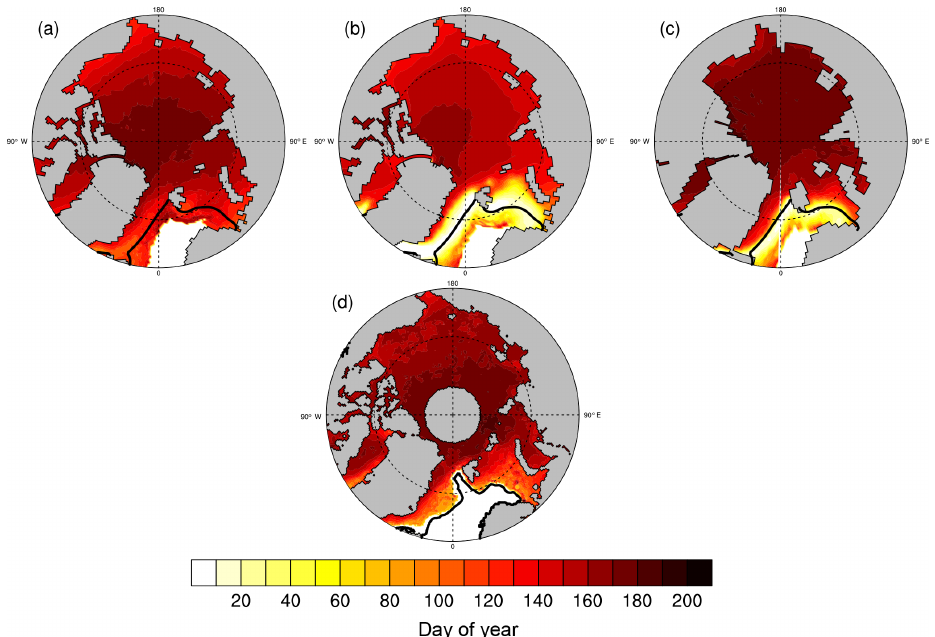
Figure 3. Average melt onset dates over 1979–2014 for each CESM LE definition using ensemble member 35: (a) snowmelt definition, (b) thermodynamic ice volume tendency definition, (c) surface temperature definition and (d) PMW satellite observations. The black line denotes the mean March ice edge (15% ice concentration) from 1979 to 2014 using (a–c) the CESM LE and (d) NSIDC Bootstrap sea ice concentrations (Comiso, 2017). Melt onset dates south of the mean ice edge are less reliable than those north of the edge. Plots from ensemble member 34 are very similar and shown in Fig. S3.